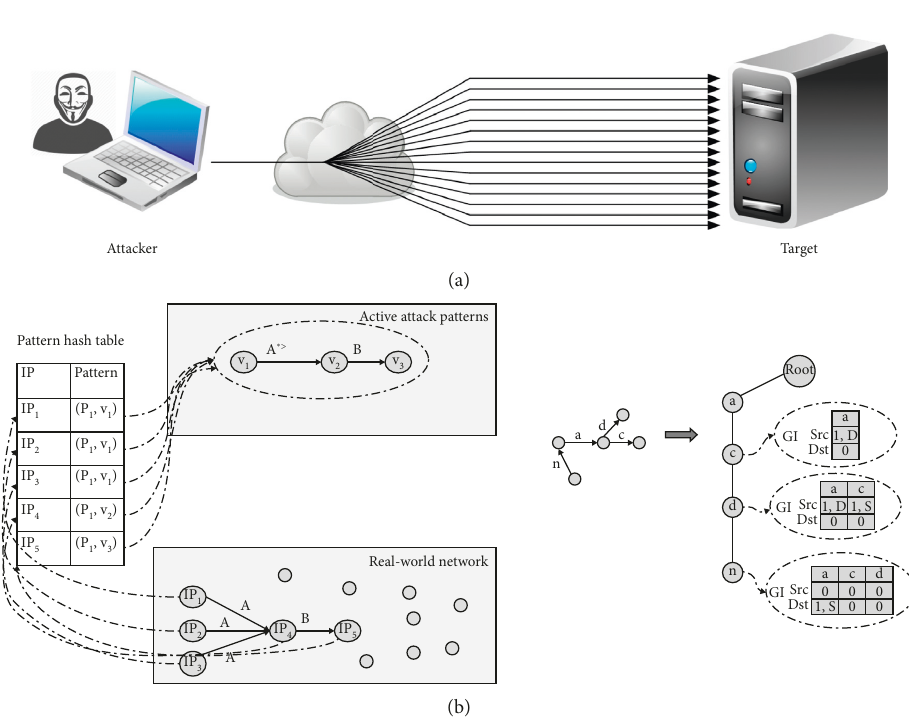
Figure 1: BFA illustration.